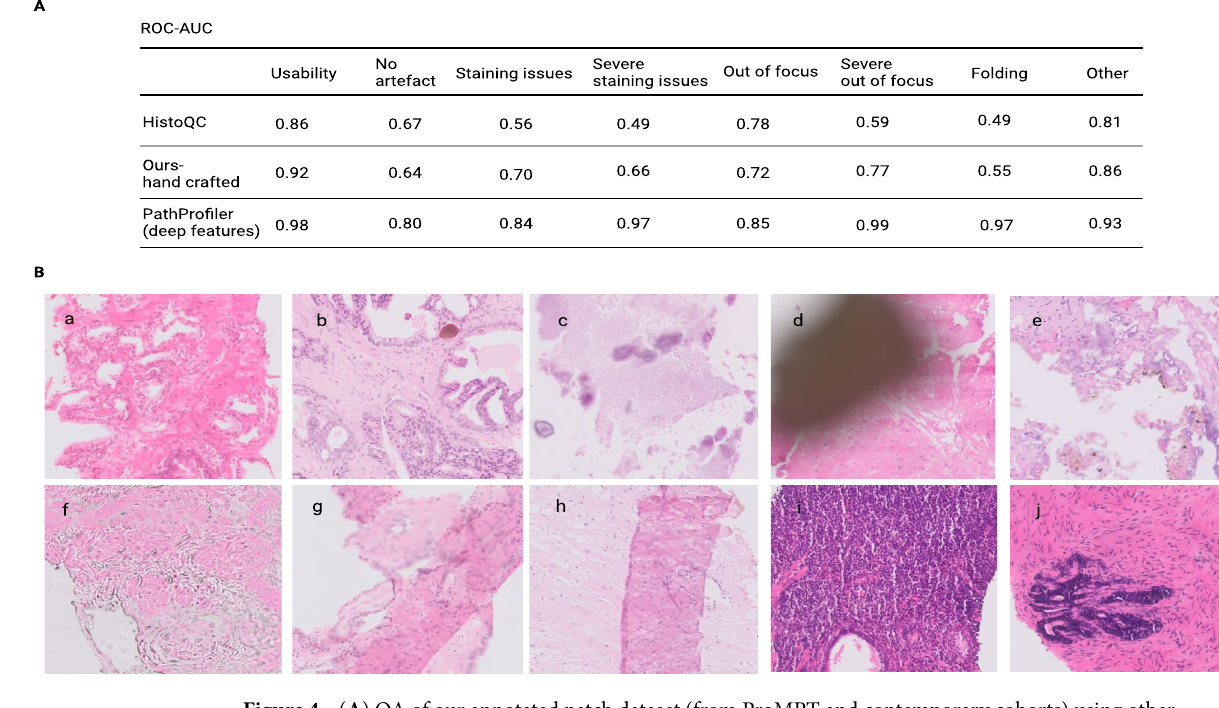
Figure 4. ( A ) QA of our annotated patch dataset (from ProMPT and contemporary cohorts) using other quality tools. ( A ) Comparison of performances of HistoQC, our proposed set of hand-crafted features, and PathProfiler for usability and artefact classification. ( B ) Examples of sample artefacts that are challenging to identify using hand-crafted features; (a, b) staining issues cannot be generally related to the brightness of images, (c, d) ‘other’ artefacts such as calcification (c) and dirt (d) that cause regions of low intensity variation are confused with out-of-focus regions. This may falsely reinforce recommendation by the algorithm for a slide re-scan, although this will not resolve those artefacts, (e, f) simple hand-crafted features such as Laplacian filtering misclassify unusable regions that contain rapid intensity changes as usable, (g, h) hand crafted features mostly associate folded tissue with darker colours in the data and therefore cannot detect folded areas within the range of average data colours, and (i, j) thicker tissue in a section may be misclassified as folded contrast, Michelson contrast, grayscale image mean, median and variance, mean of filtered image with Gaussian, Laplace, Frangi and Gabor filters, Local binary patterns (LBP), per channel mean of RGB and HSV and decon- volved H&E stain channels (available at https:// github. com/ choos ehappy/ Histo QC). We also tried a different set of hand-crafted features that performed better overall on our dataset in compari- son with HistoQC feature set, as shown in Fig. 4A (denoted ‘Ours-hand crafted’). The features include Modified Laplacian (LAP2) 27 focus measure, Variance of Laplacian, TenenGrad contrast, average difference of image from Gaussian filtered image, average variance along R, G and B channels (along third axis), per channel mean of RGB, HSV and deconvolved H&E stain channels and Otsu threshold. The ROC-AUC of classifiers generated using HistoQC features and our set of hand-crafted features versus PathProfiler are reported in Fig. 4A. As seen, the performance of our multi-task deep learning model in PathProfiler was superior to classifiers that used HistoQC